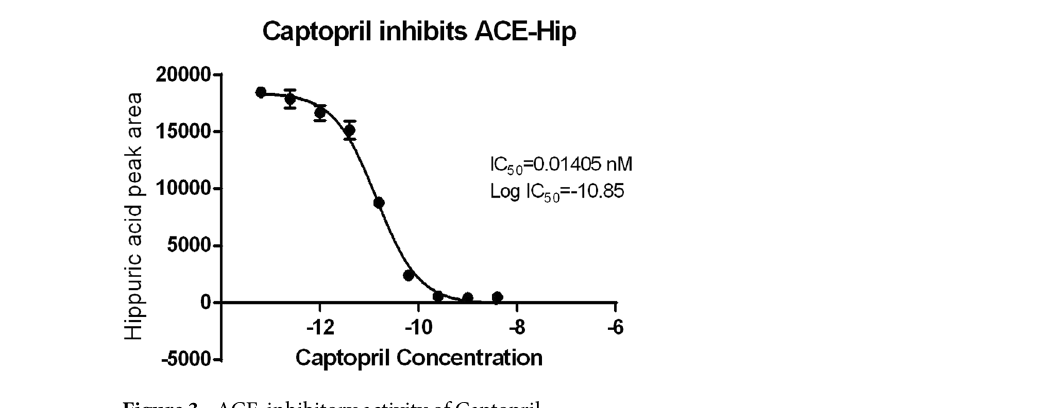
Figure 3. ACE-inhibitory activity of Captopril.